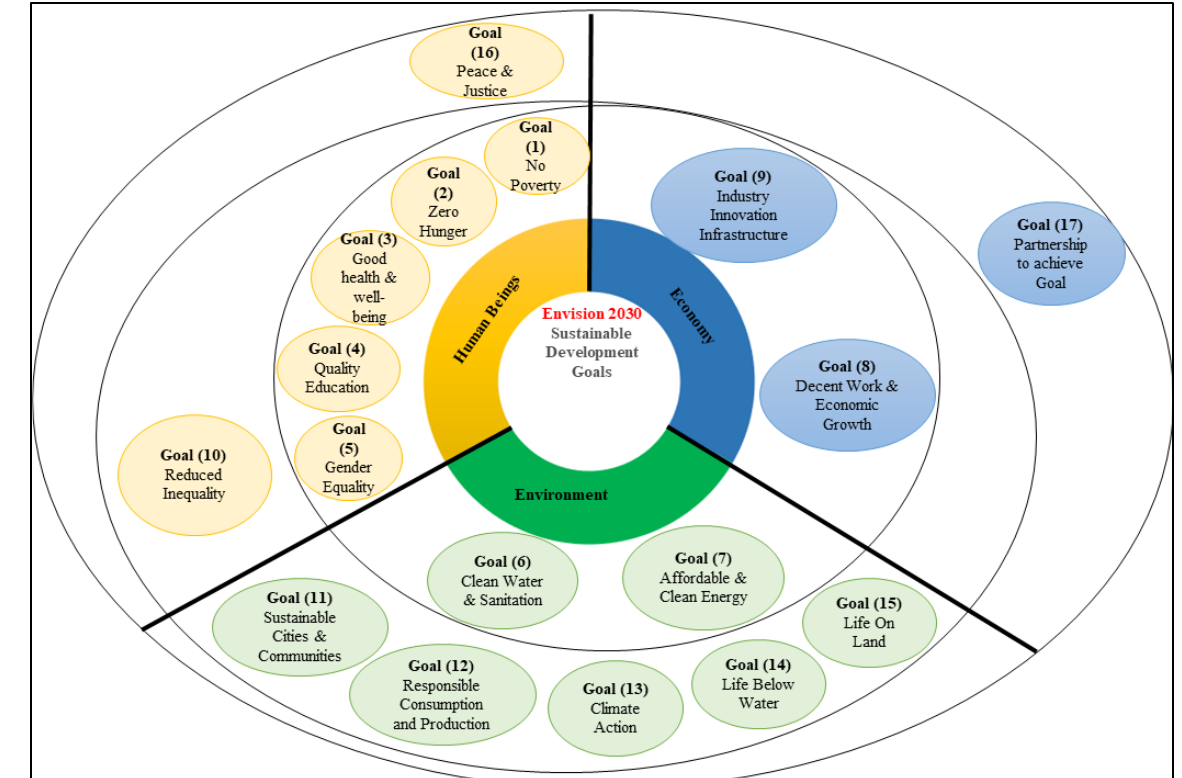
Figure 1. Global sustainable goals .